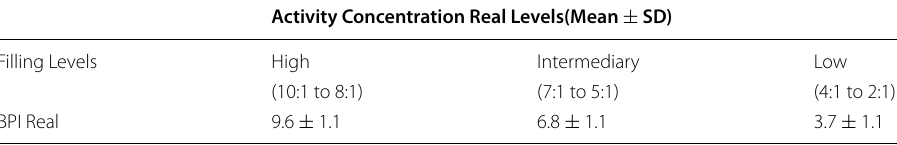
Table 1 Average proportions of the actual filling concentrations, simulating different concentrations of activity present in the compartments of the